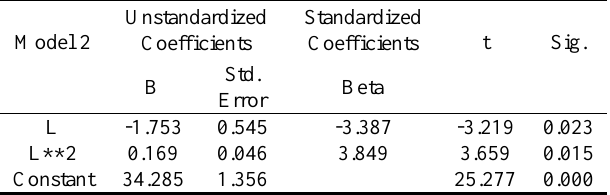
Tab.11. The anova of regression model